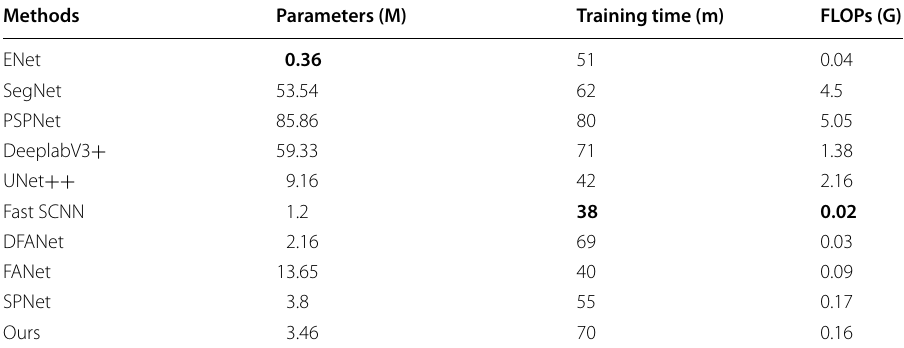
Table 2 Comparison of parameters (M), training time (m) and FLOPs (G) between our method and other segmentation networks, in which highlighted values represent the best result of each criteria Methods